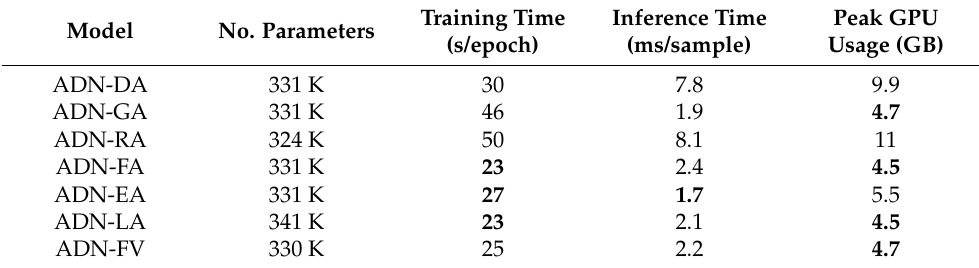
Table 2. Time and resource utilization of different attention types for ADN on Metr-LA.